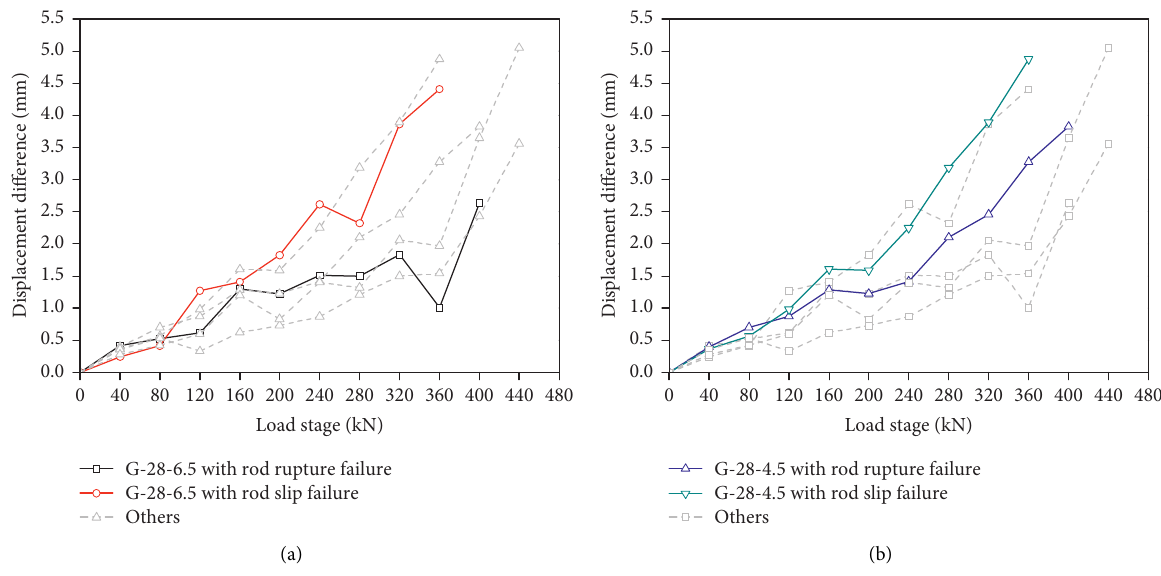
Figure 20: Load-displacement difference curves of the anchors with different failure modes: (a) G-28-6.5 and (b) G-28-4.5.